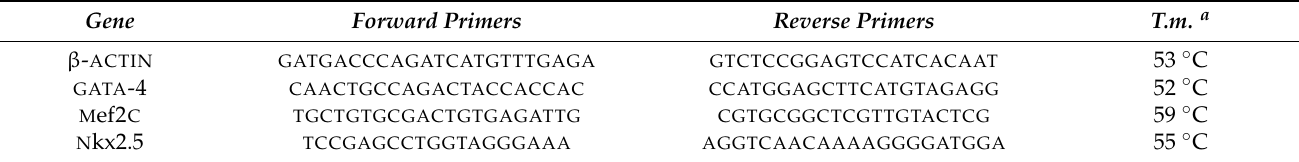
Table 1. Primers used for qRT-PCR.